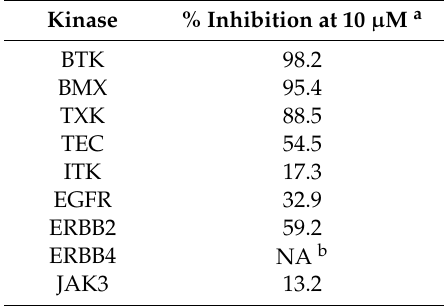
Table 2. Kinase selectivity profile of compound 8